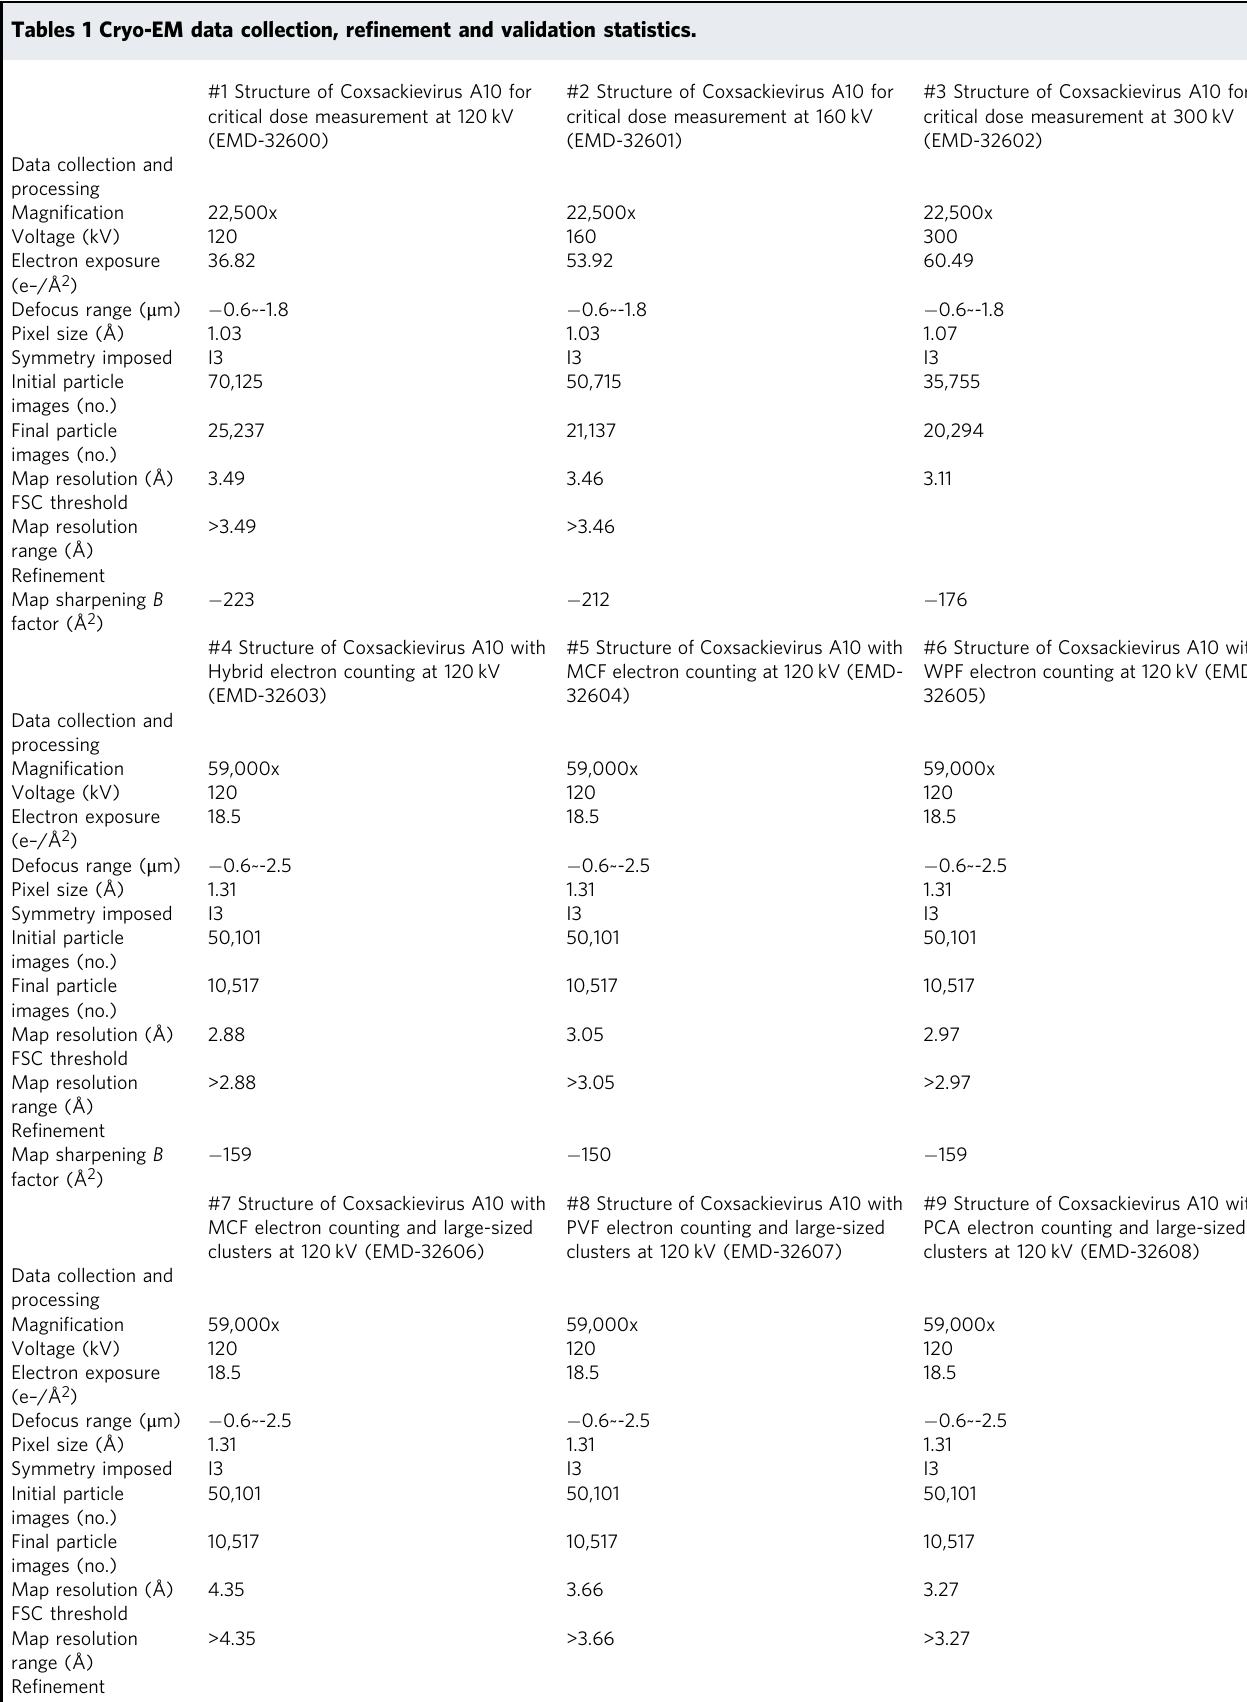
Tables 1 Cryo-EM data collection, re fi nement and validation